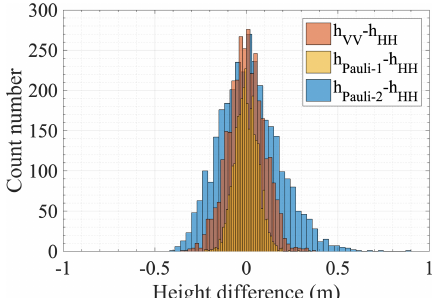
Figure 6. Height difference between the InSAR-derived height ( h InSAR ) in HH polarization and the other three polar- izations.